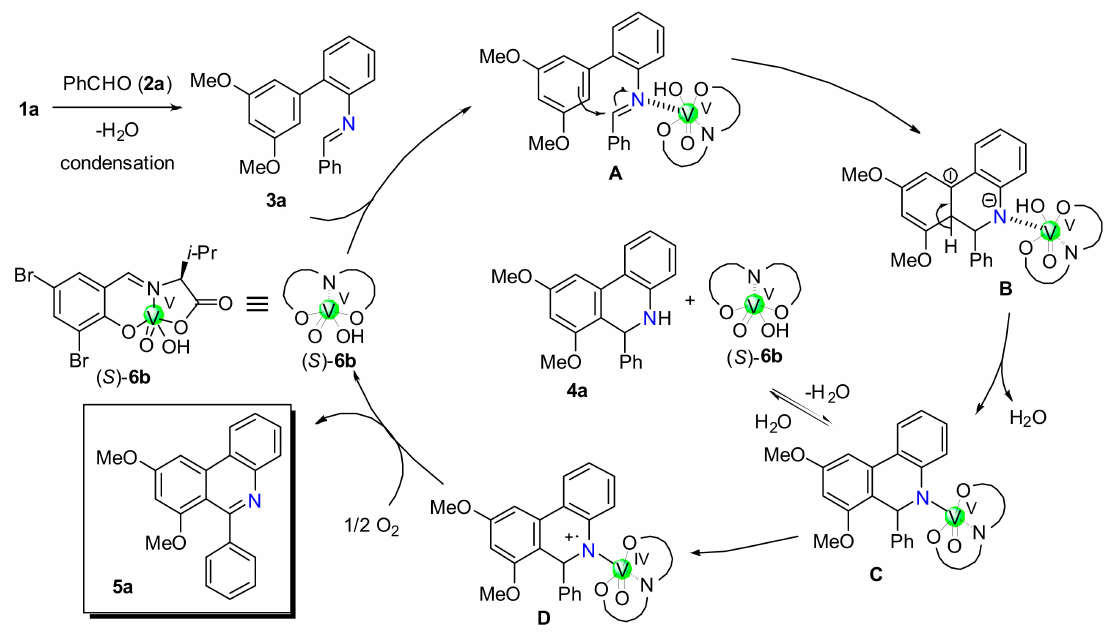
Figure 3. A plausible catalytic cycle for the vanadium(V)-catalyzed Pictet-Spengler-dehydrogenative aromatization cascade reaction of aniline 1a and benzaldehyde 2a